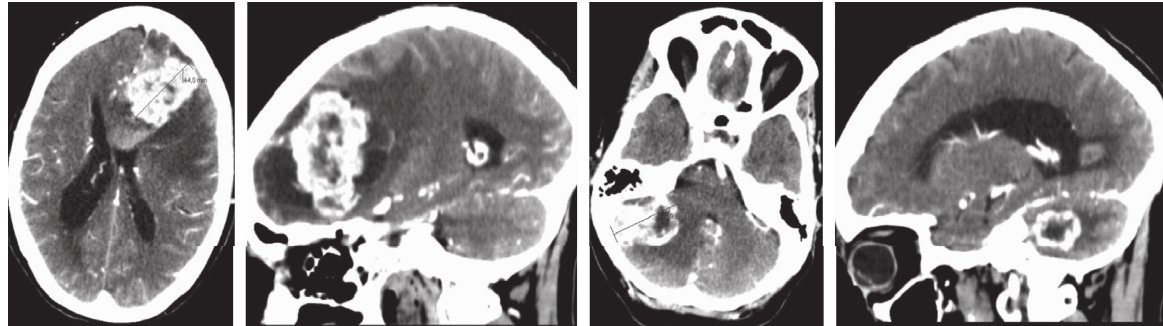
Figure 1: Enhanced CT scan showing 2 lesions with halo of edema, left frontal and right cerebellar. The frontal lesion had an associated bleeding area of 3 cm in diameter.